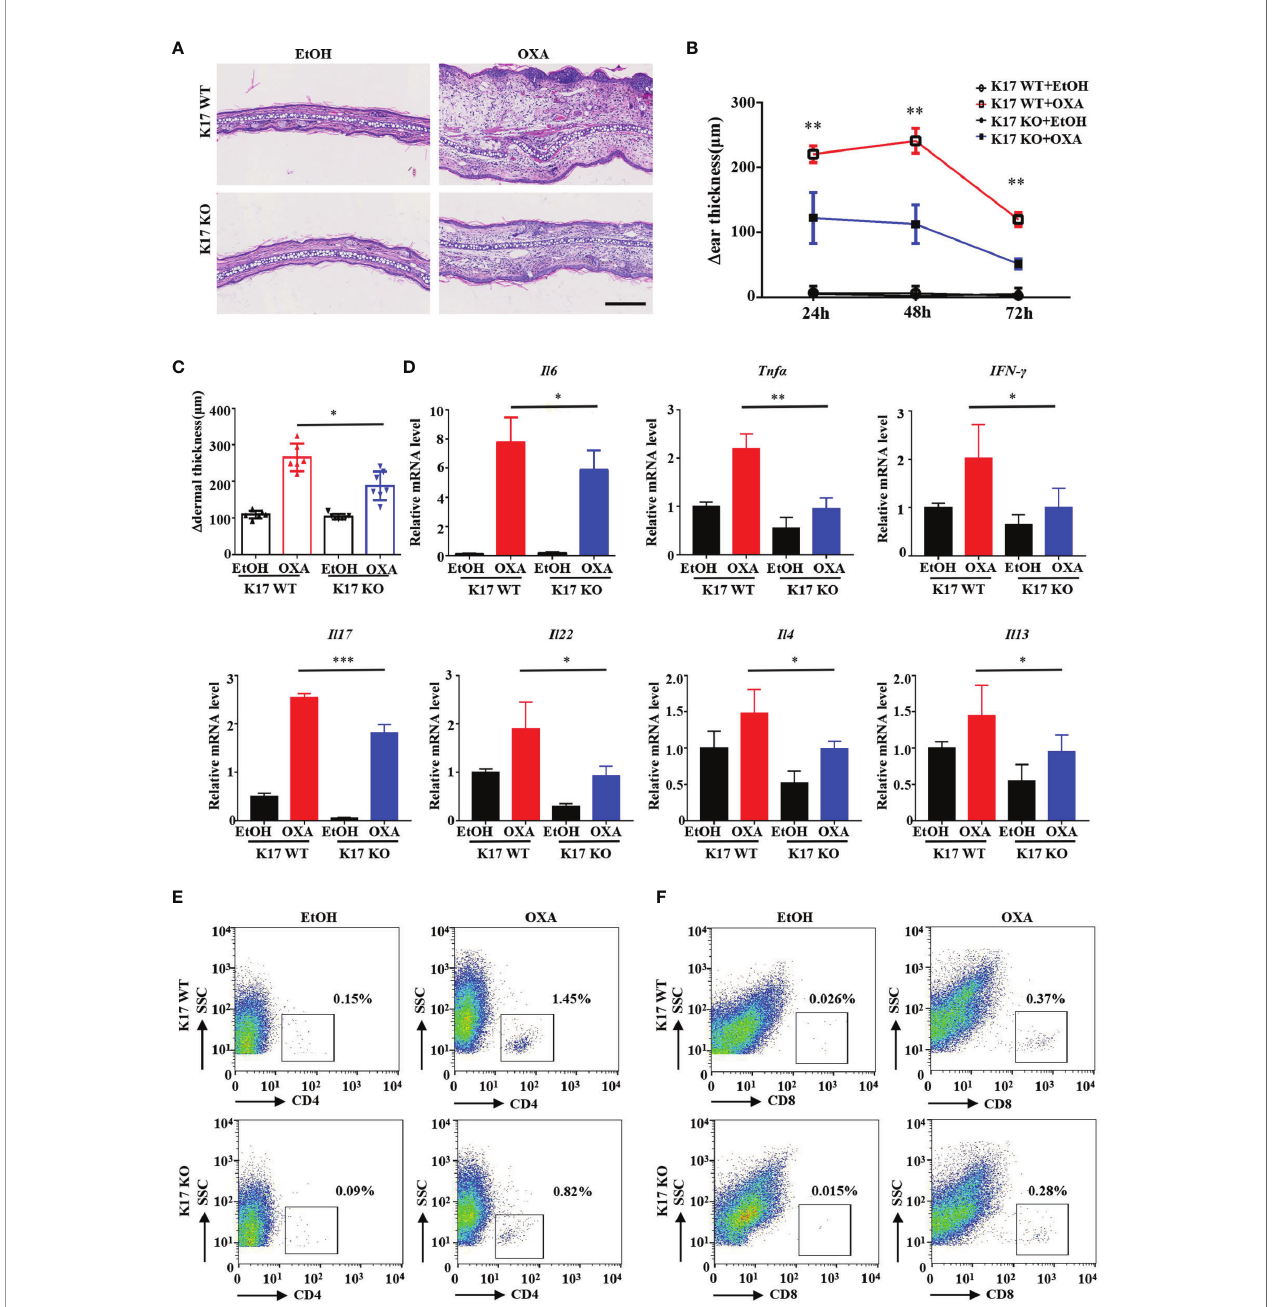
FIGURE 2 | K17 de fi ciency attenuates OXA-induced ACD-like skin in fl ammation. (A) H&E staining of sections from K17 KO and K17 WT mice at 24 h after challenge with OXA or ethanol. Scale bar, 10 m m. The study involved 3-5 mice per group and 3 independent experiments. Examination of (B) D ear thickness and (C) D dermal thickness, n = 3 per group (D) Relative Il6 , Tnfa , IFN- g , Il17 , Il22 , Il4 and Il13 mRNA expression in the mouse epidermis, n = 5 per group. The percentage of (E) CD4 + T cells and (F) CD8 + T cells gated from live cells was quanti fi ed using fl ow cytometry. Data represent the mean ± SD ( n = 3). * p < 0.05, ** p < 0.01, *** p < 0.001. All the bars represent at least average of three independent